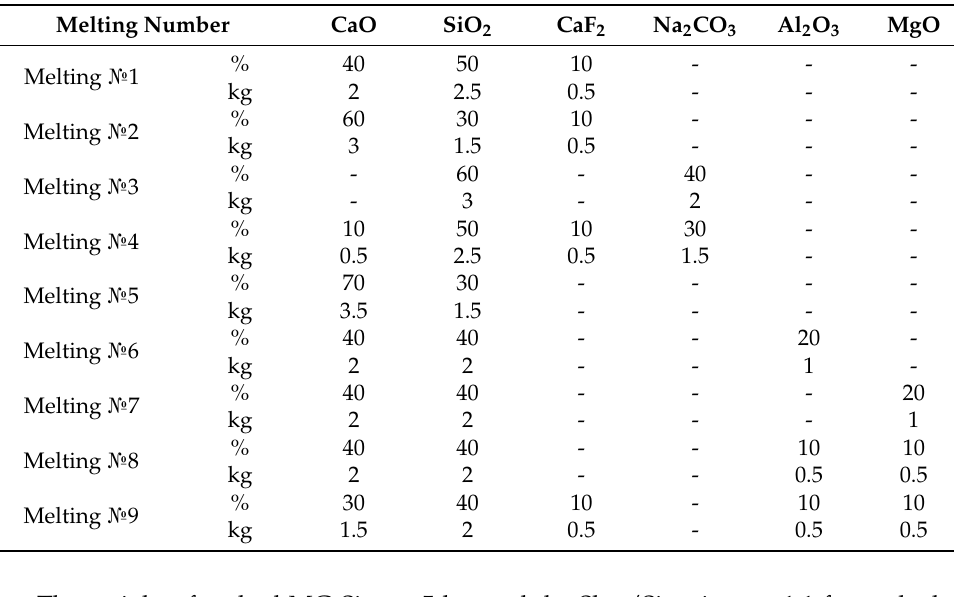
The weight of melted MG-Si was 5 kg, and the Slag/Si ratio was 1:1 for each slag refining process. Photos of the obtained ingots are shown in Figure 2.